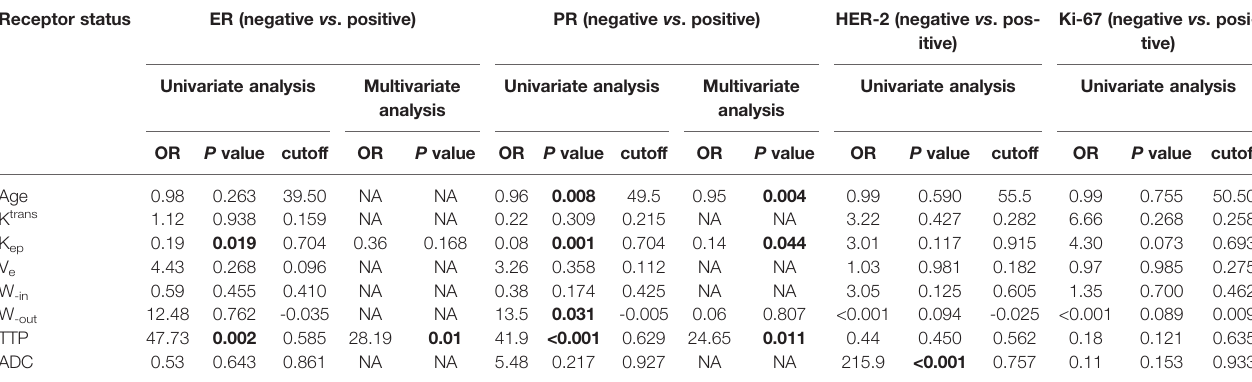
OR, Odds ratio; NA, Not available; ER, Estrogen receptor; PR, Progesterone receptor; HER-2, Human epidermal growth factor receptor-2; ADC, Apparent diffusion coef fi cient. Bold values indicate statistically signi fi cant in P values.